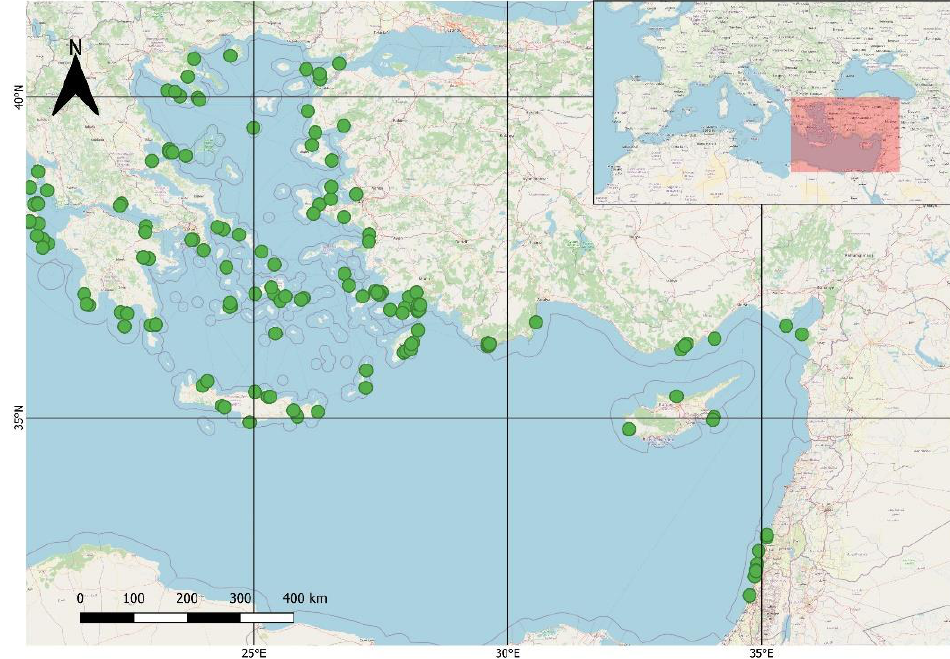
Figure 3. Records of Gobius incognitus in the eastern Mediterranean.